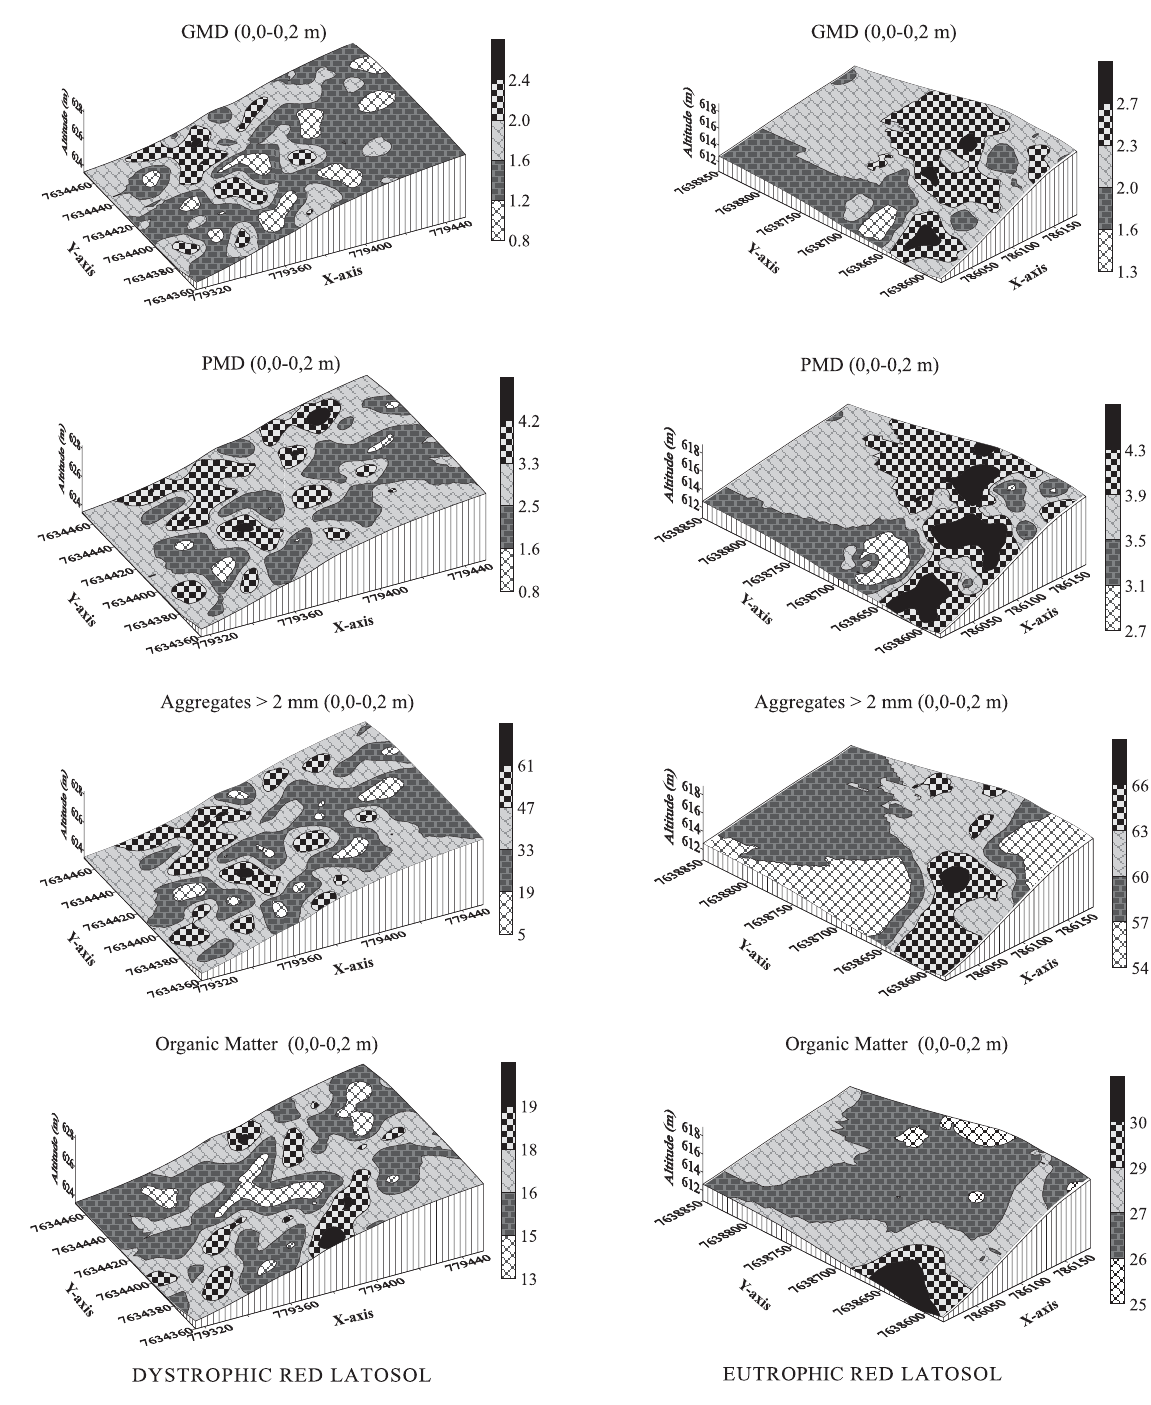
Figure 2. Spatial distribution of the variables geometric mean diameter (mm), mean weight diameter (mm), aggregates in class > 2.0 mm (%) and organic matter proportion (g dm -3 ), in an eutrophic Red Latosol (ERL) and a dystrophic Red Latosol (DRL) in 0.0–0.2 m